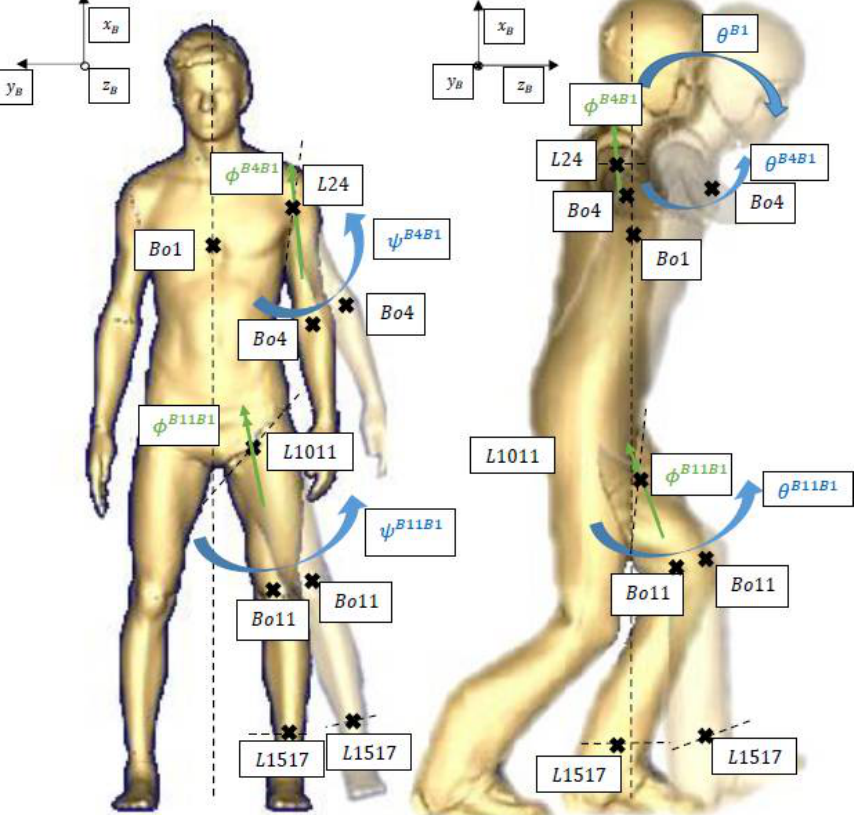
Figure 2. MBS model of ski jumper with different bodies and movement directions and rotation axes